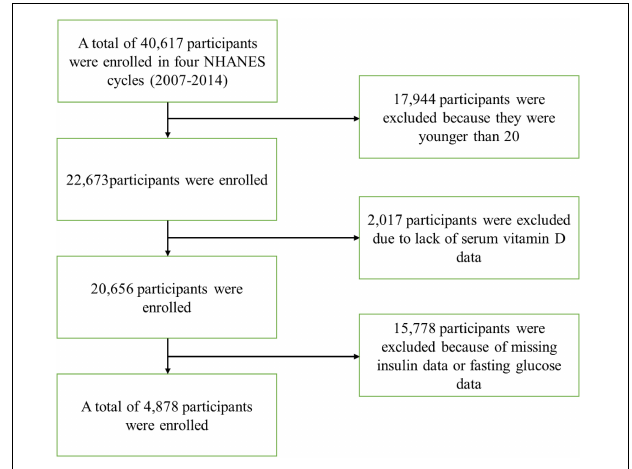
FIGURE 1 | Flowchart of patient